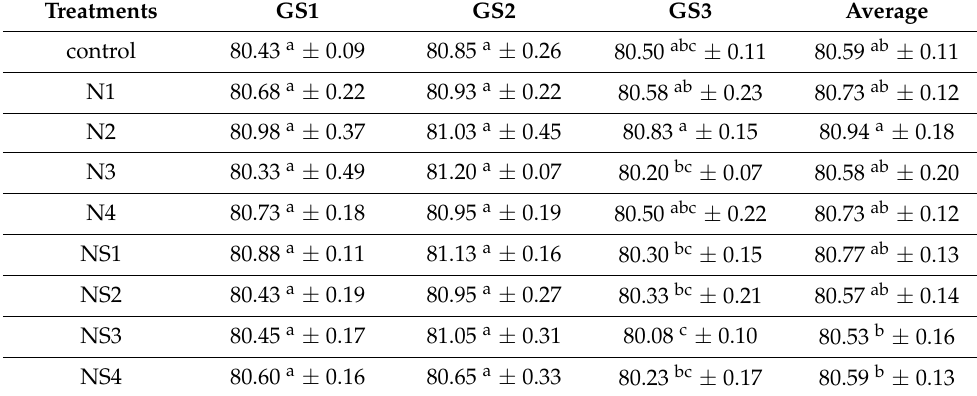
Table 5. The effect of fertilizer treatments on the hectoliter weight of the wheat grain (kg/hL).